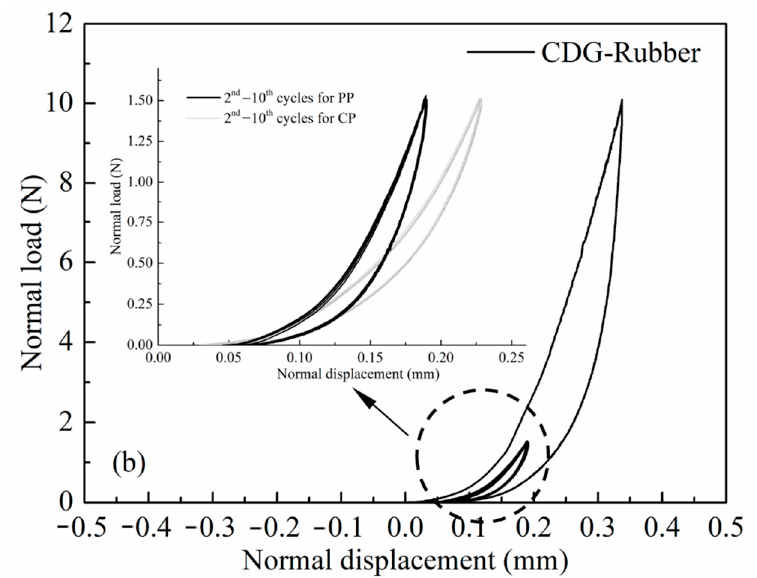
Figure 13. Load–displacement curves of preloading tests for ( a ) LBS–rubber and ( b ) CDG–rubber contacts and their comparisons with cyclic tests (inset Figures).